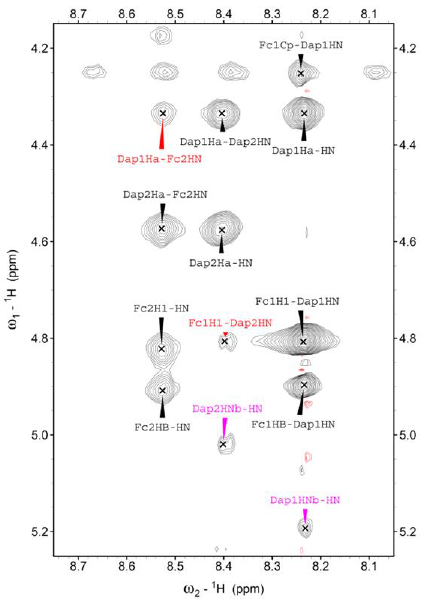
Figure 3. Region of the NOESY spectrum of 2 in CDCl 3 solution, T = 25 °C.